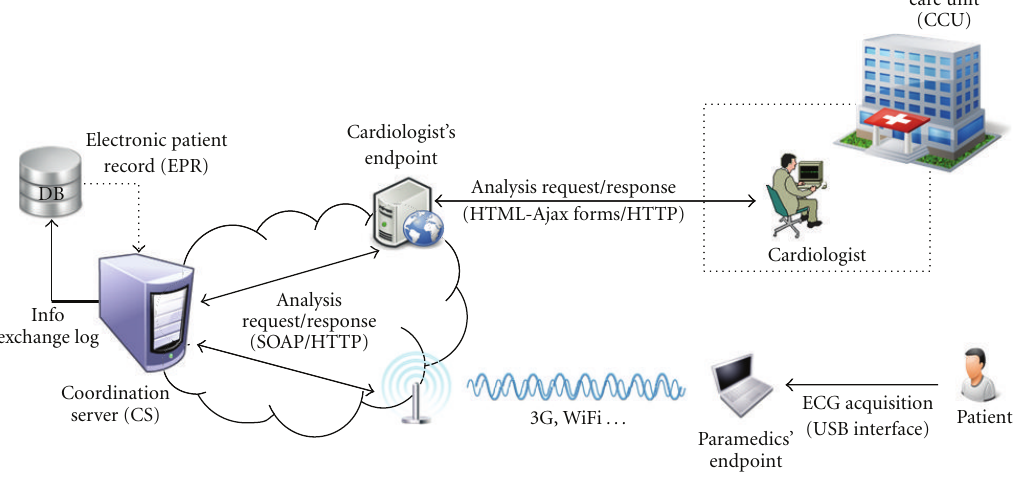
Figure 1: AToMS’ system